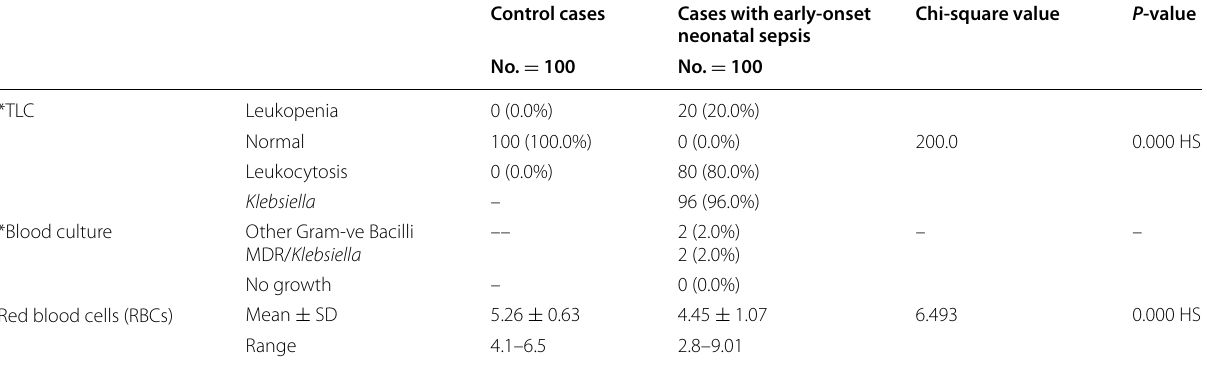
Table 1 Comparison between controls (no. culture, and RBCs